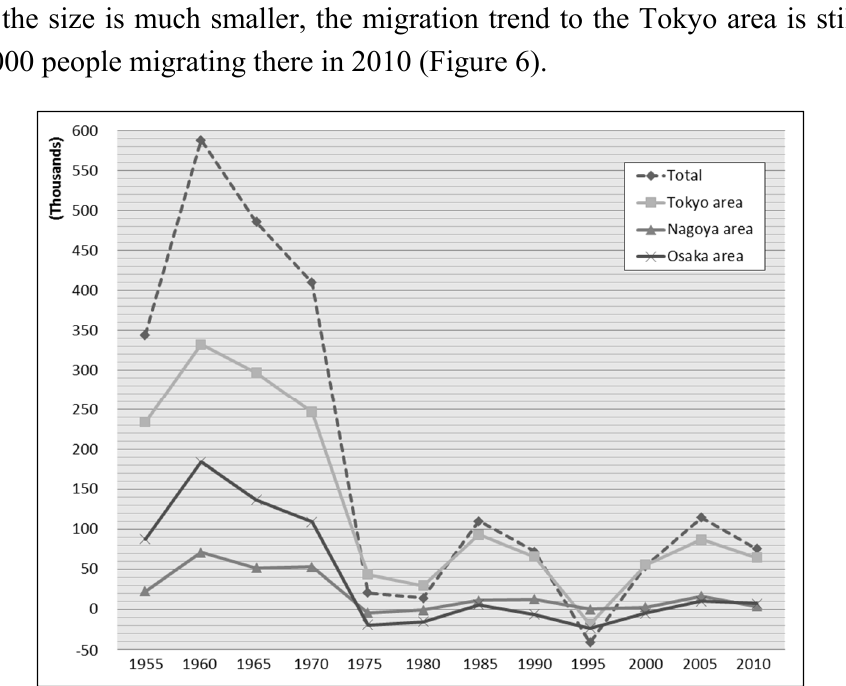
Figure 6. In-migration of three major city areas in Japan from 1955–2010. Note: Created from the report on Internal Migration in Japan by the Ministry of Internal Affairs and Communications. Counted numbers show only Japanese nationality. Area definitions